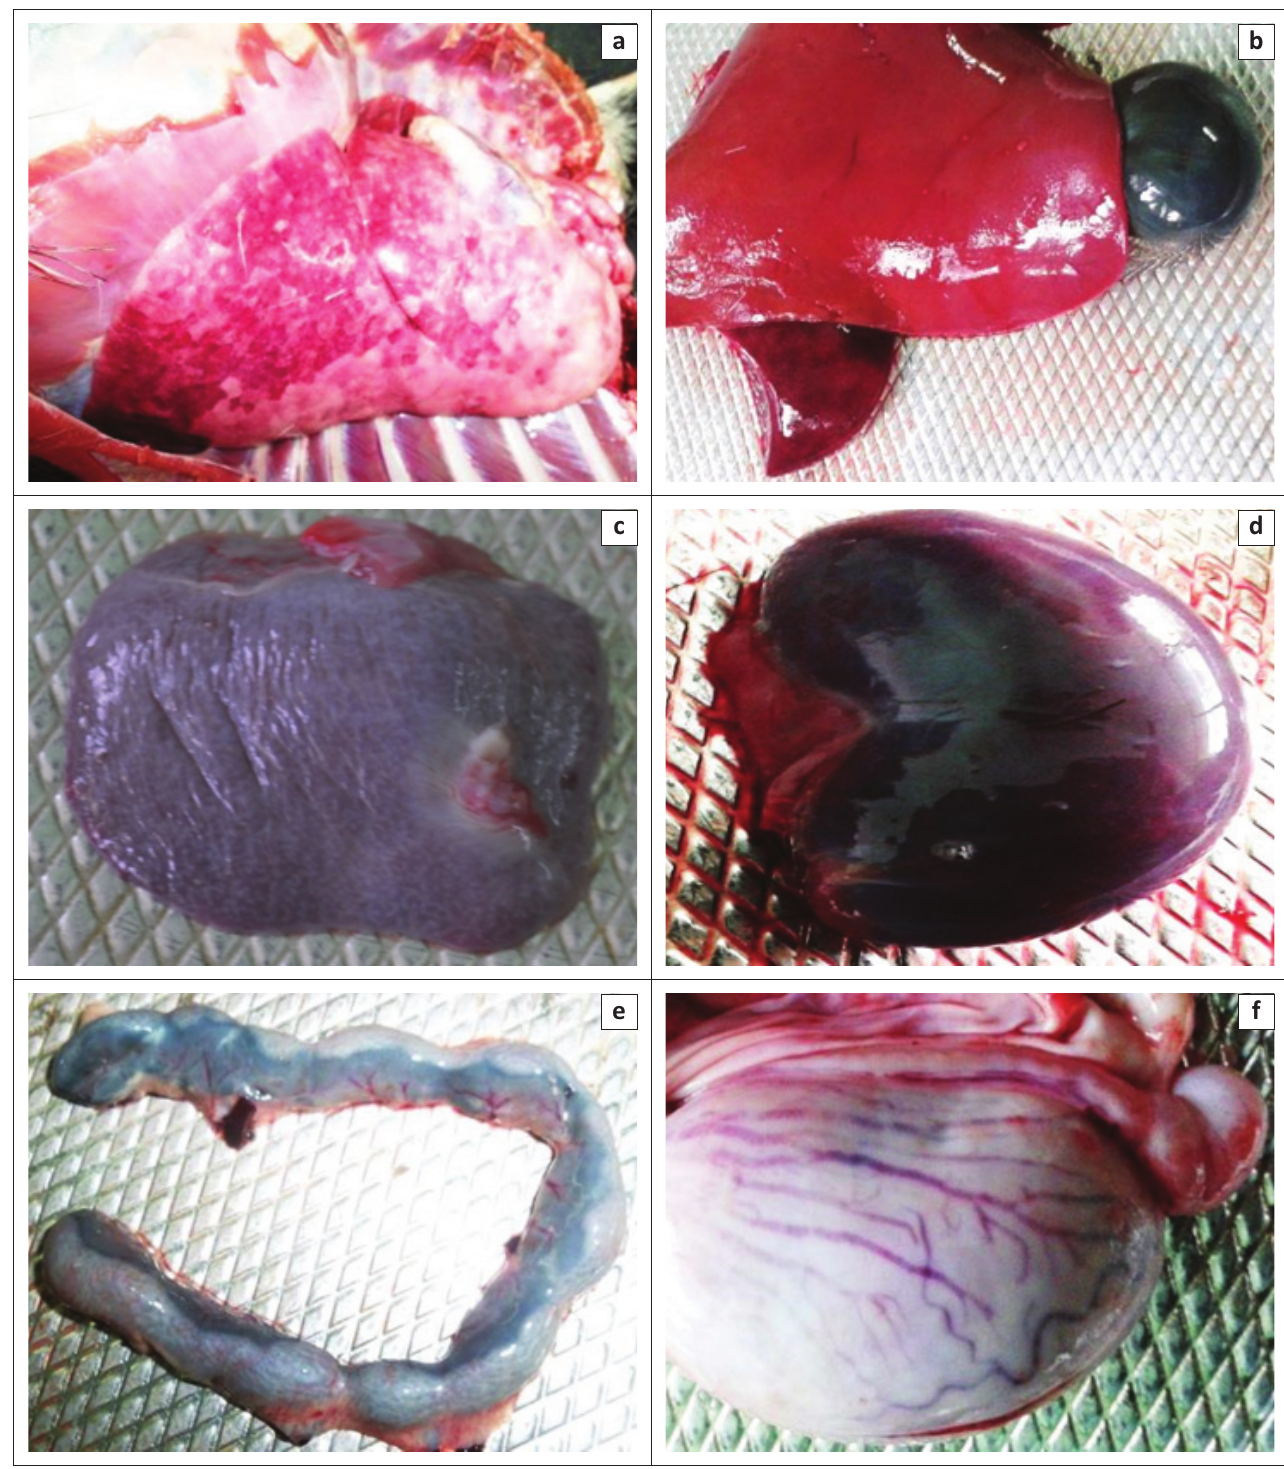
FIGURE 1: Post-mortem examinations of peste des petits ruminants –infected Black Bengal goats showed severe haemorrhage and congestion of visceral organs. (a) Lungs showed severe congestion with white necrotic foci on the surface. (b) Congested and fragile liver and (c) atrophy of the spleen. (d) Kidneys showed congestion and (e) mesenteric lymph nodes were enlarged and congested. (f) Congestion and swelling of testis were found in peste des petits ruminants –infected male goat. Representative images of one out of seven dead goats are